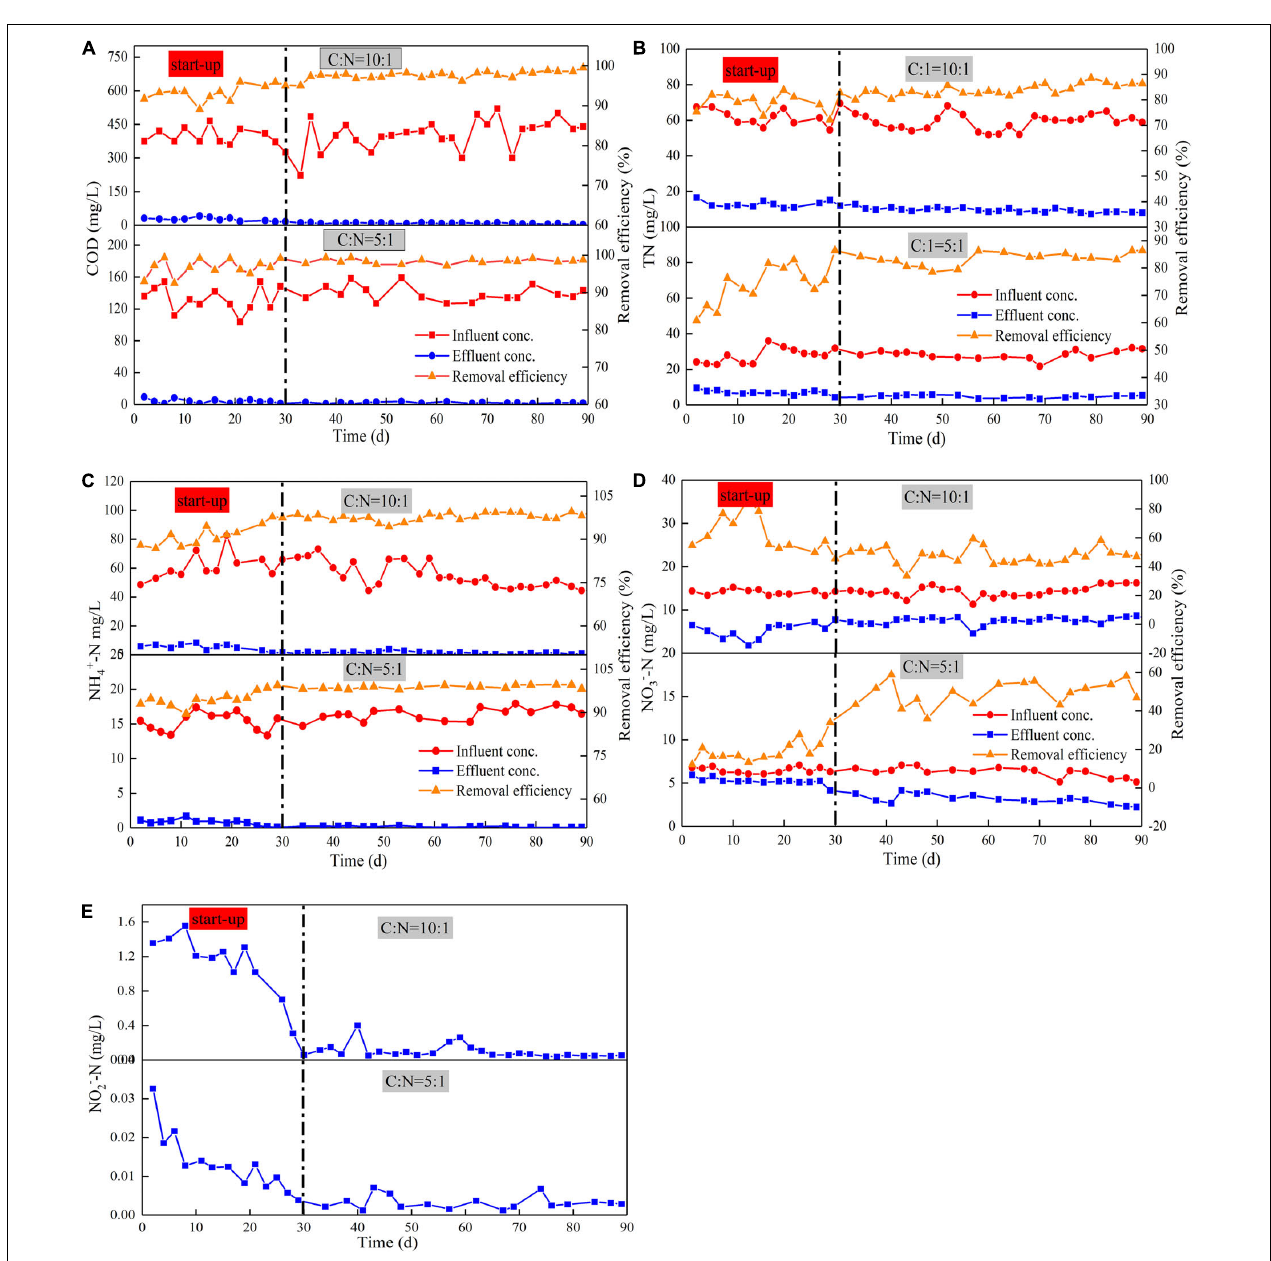
FIGURE 2 | Average removal efficiency and change in concentrations of COD (A) , TN (B) , NH 4 + -N (C) , NO 3 – -N (D) , NO 2 −−− N, (E) with various C/N ratios.